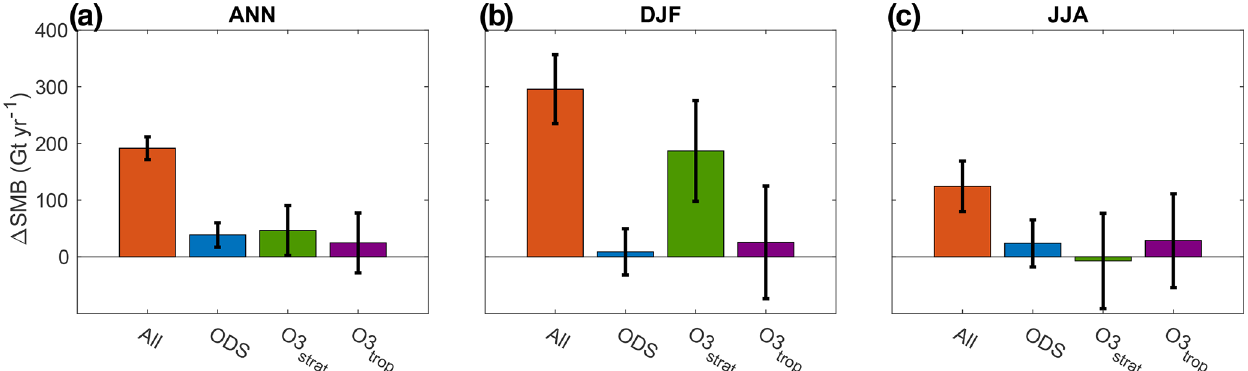
Figure 1. Antarctic SMB response to second half of the 20th century forcing ( (cid:49) SMB) in (a) annual mean, (b) DJF and (c) JJA. Red bars show the response in the full forcing ensemble mean (All). The blue, green and purple bars show the contributions of ODSs, stratospheric ozone (O3 strat ), and tropospheric ozone (O3 trop ) to the SMB response, respectively. Error bars represent the 95% confidence interval.